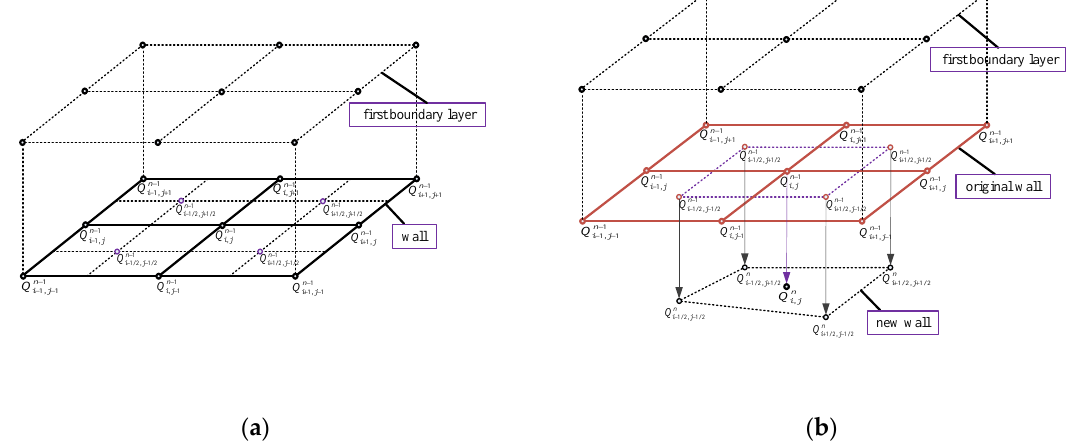
Figure 3. Erosion profile calculation with dynamic mesh: ( a ) before collision; ( b ) after collision.